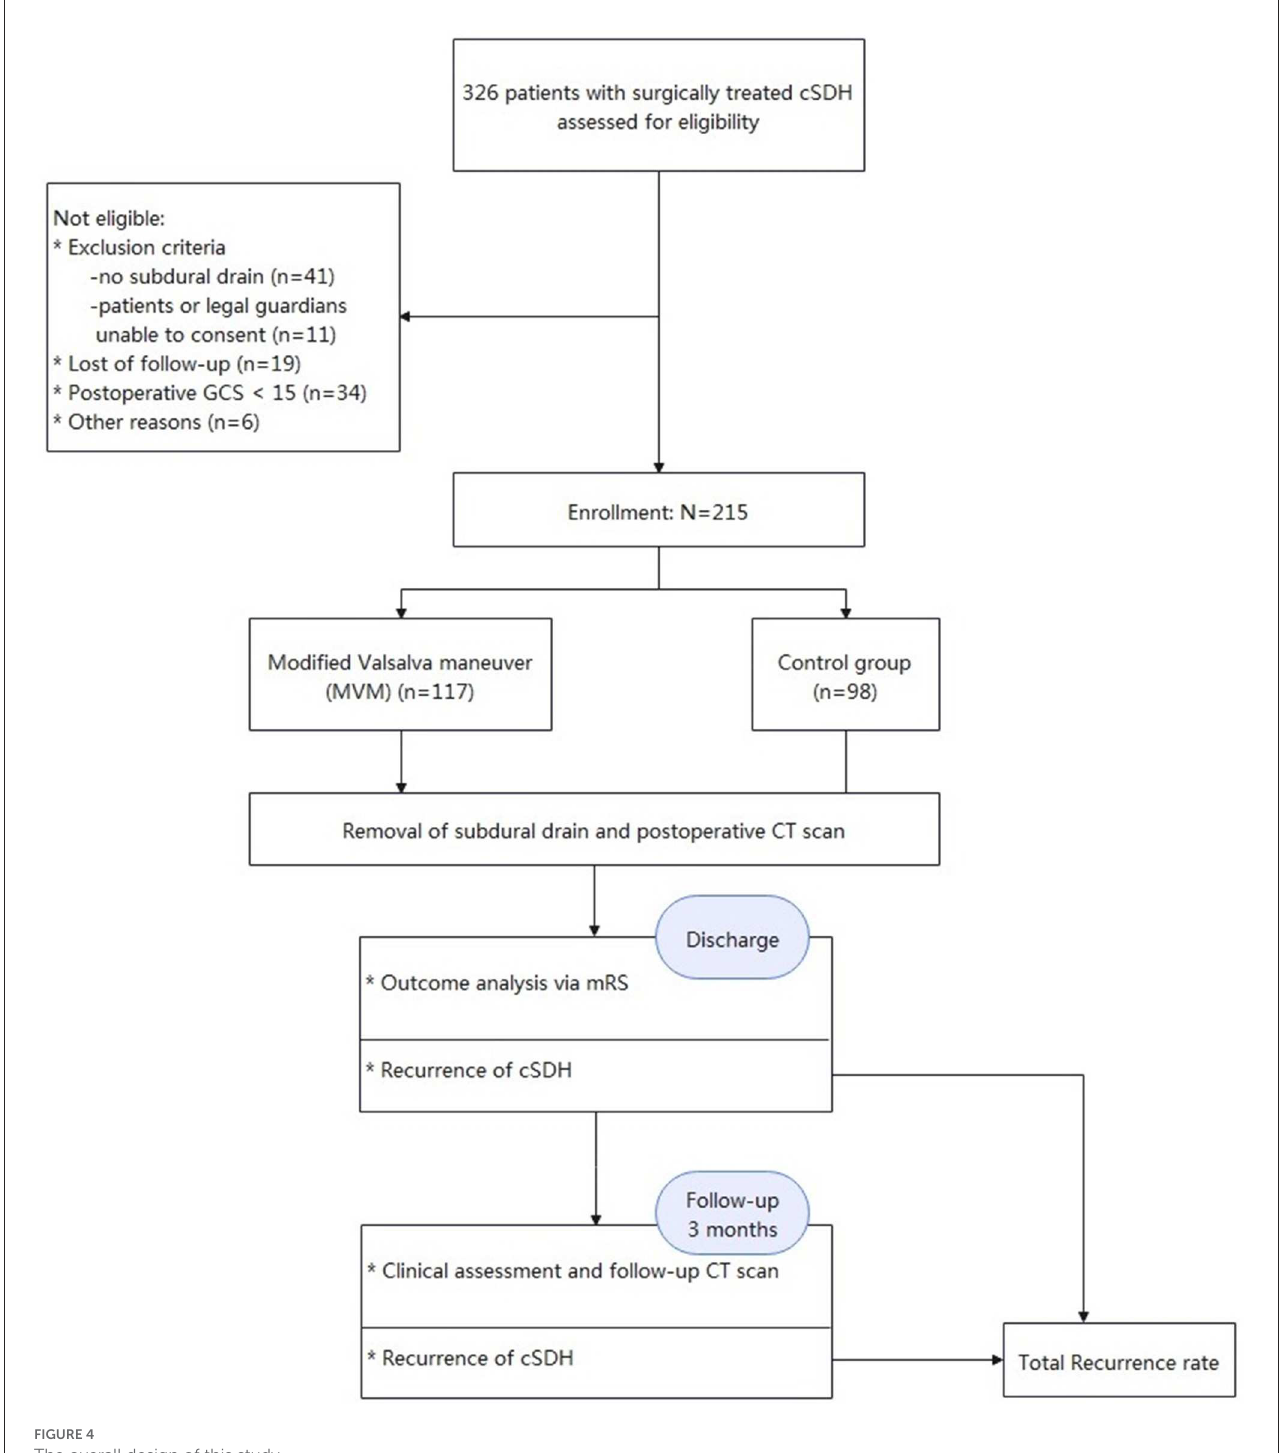
FIGURE4 The overall design of this